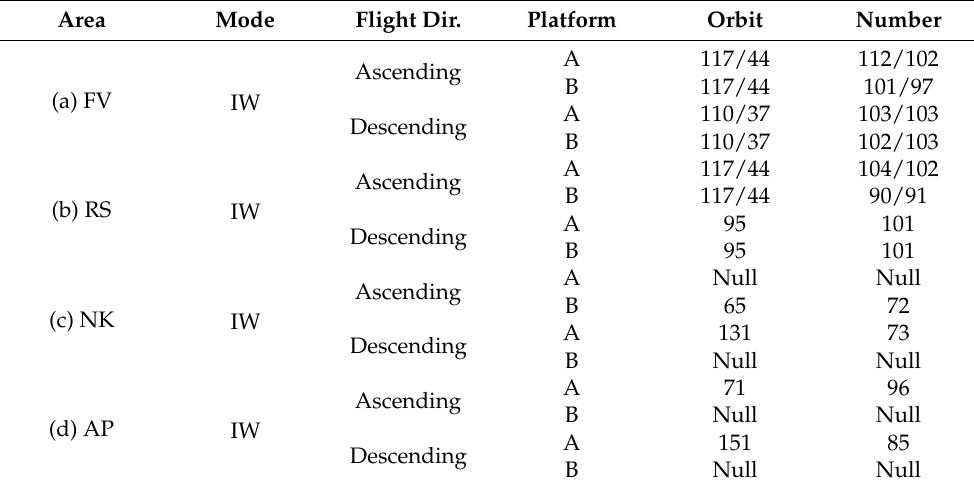
Table 2. Image acquisition mode and the number of images from different satellites (Platform) in different orbits (ascending and descending) for the four study areas between November 2016